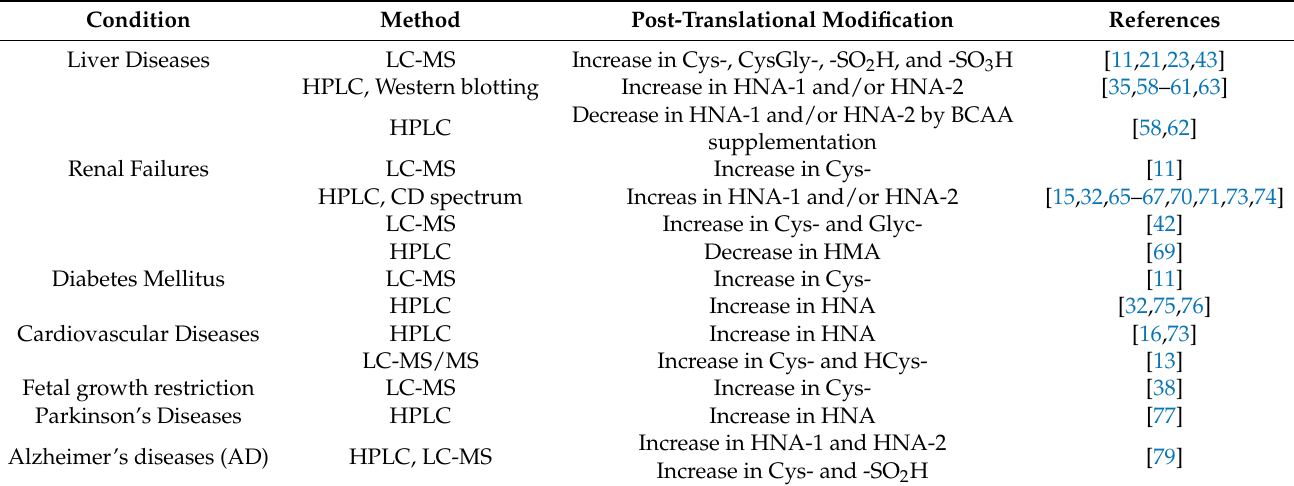
Table 2. Serum albumin (ALB) redox state in pathological